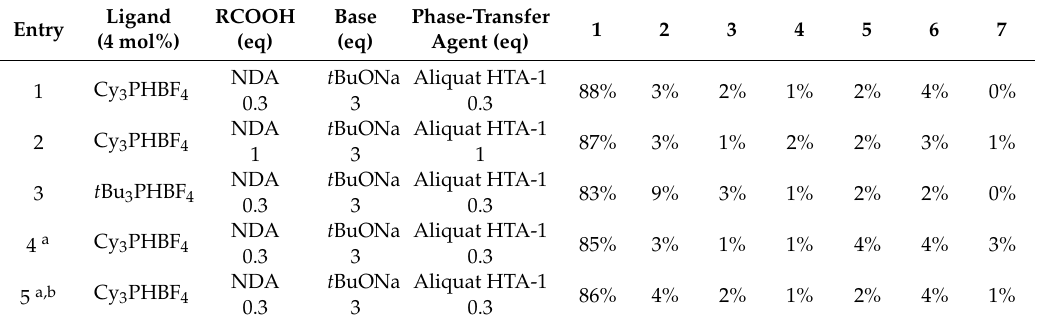
Table 2. Optimization of reaction conditions for the DHA coupling between 2-hexylthiophene and 4-bromoanisole in the emulsion medium. All reactions were carried out in a pressure-tight 10 mL screw-cap glass tube under magnetic stirring at 1000 rpm for 24 h and at a nominal concentration for the reagents of 0.5 mol / L. RCOOH stands for the carboxylic